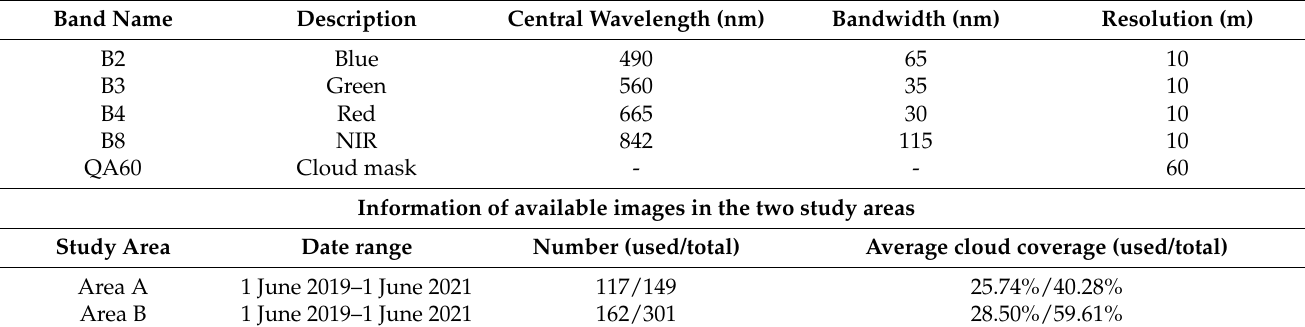
Table 2. Sentinel-2 L2A products information in the selected bands and Sentinel-2 L2A image information at the two study